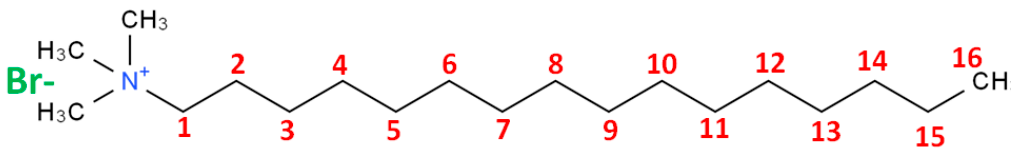
Figure 1. The chemical structure of the C16TMABr salt.